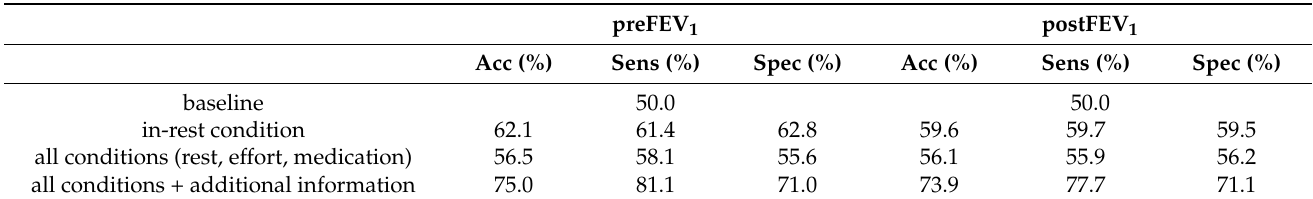
Table 5. Accuracy (Acc), sensitivity (Sens) and specificity (Spec) values for the automatic classification of FEV 1 given a reference